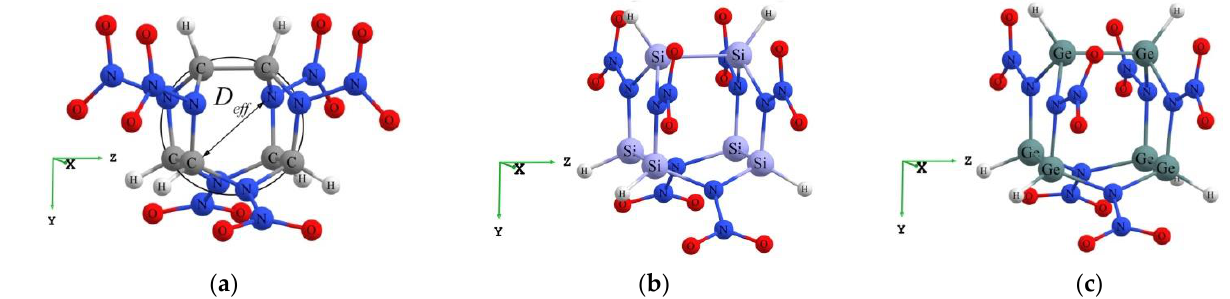
Figure 1. ( a ) — The isolated molecule CL-20; ( b ) — the isolated molecule Si 6 CL-20; ( c ) — the isolated Figure 1. ( a )—The isolated molecule CL-20; ( b )—the isolated molecule Si 6 CL-20; ( c )—the isolated molecule Ge 6 CL-20. molecule Ge 6